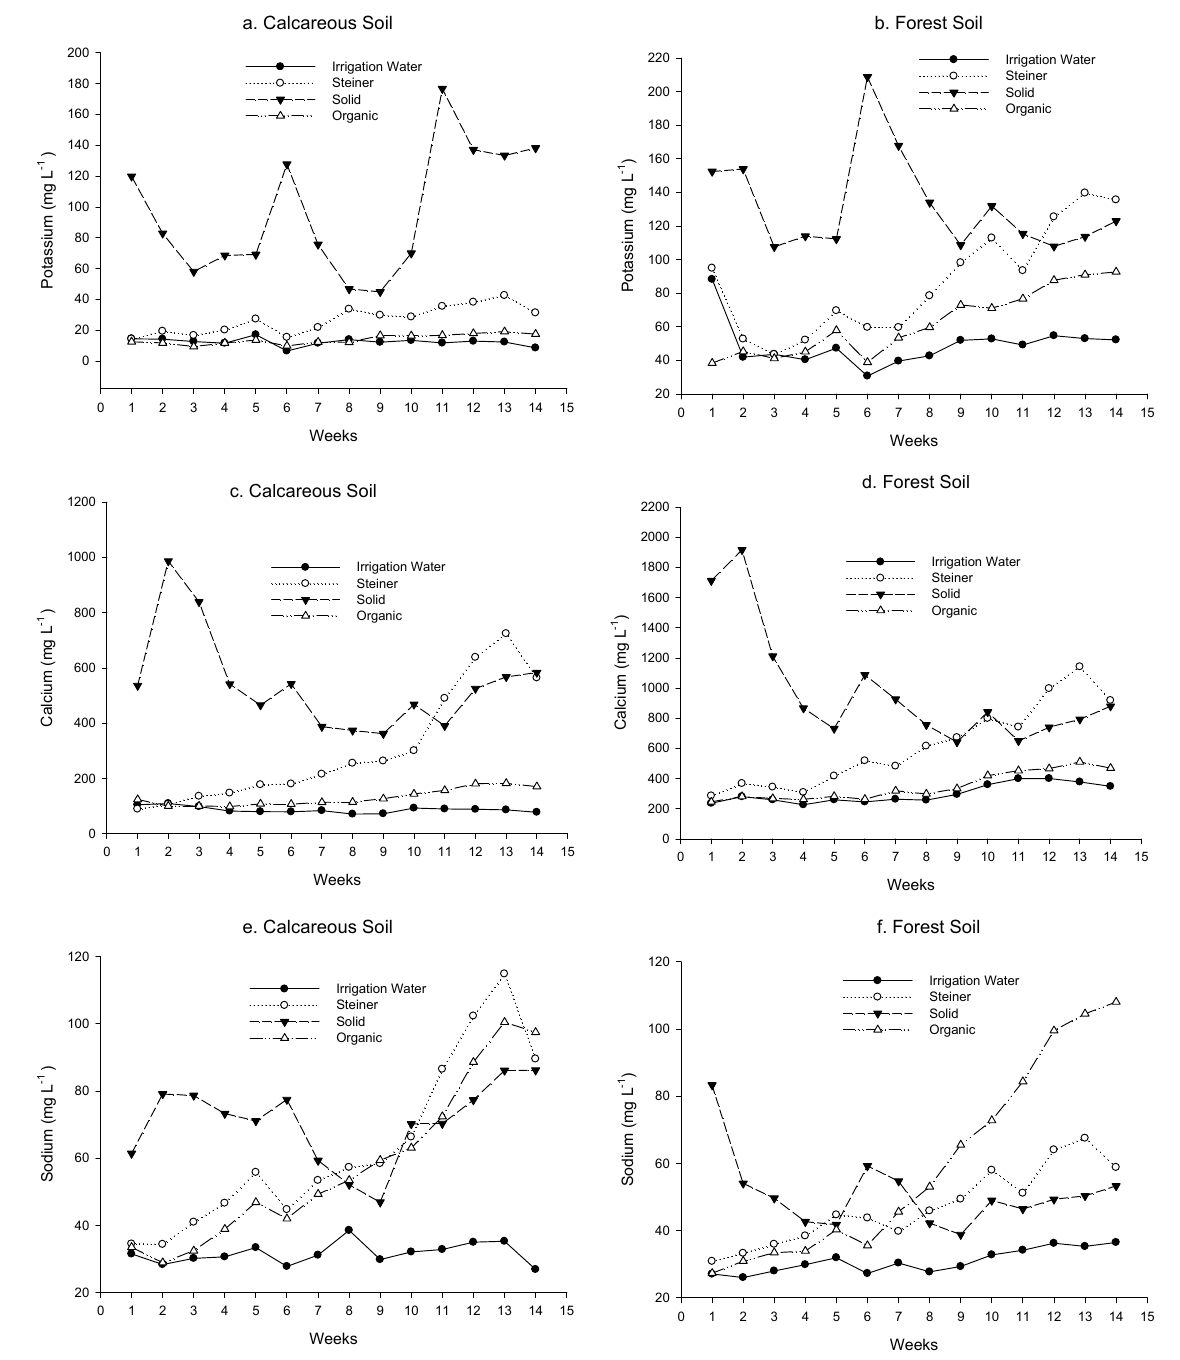
Figure 4. Potassium, calcium, and sodium dynamics, determined in soil solution samples for calcareous and forest soils under pot and greenhouse conditions under different nutrient supply scenarios, using inorganic fertilizers: nutrient solution (Steiner) and fertilizers in fractional (solid) form and organic fertilizer with vermicompost tea (aqueous extract).